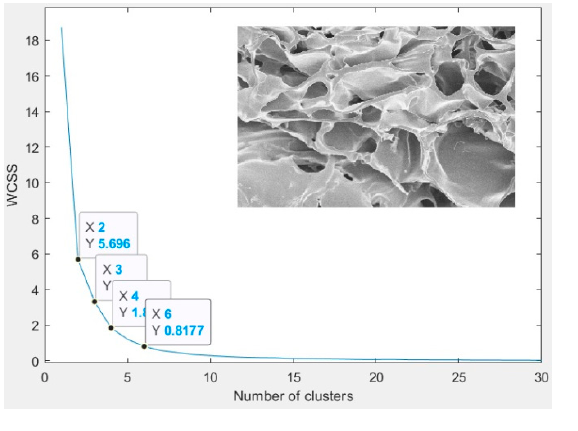
Figure 3. The flow chart of K -means clustering.